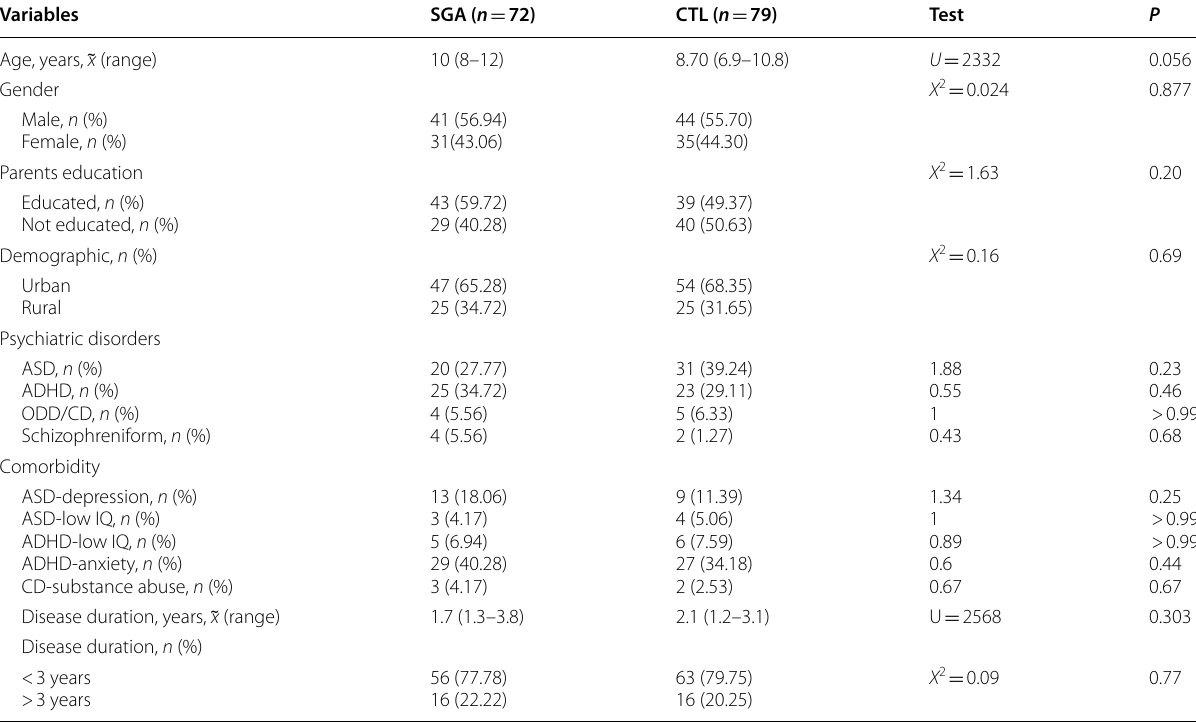
Table 1 Socio-demographic characteristics, presented clinical psychiatric disorders and disease duration of SGA-treated and control